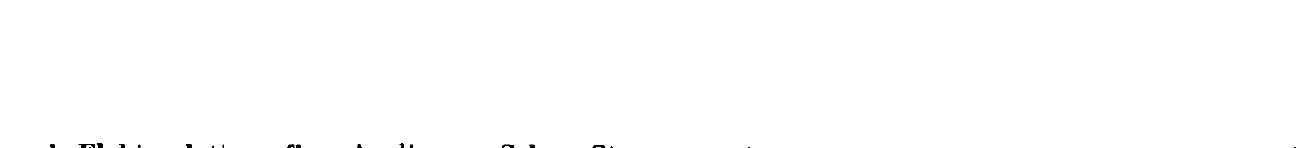
glottale lugdruk wat vir klankpeilvariasie benodig word. Tydens harde fonasie kom die grootste gem. fo- verhoging by die 70-80 jaar voor. Verskeie outeurs rapporteer 'n toename in die veranderlikheid van gem.